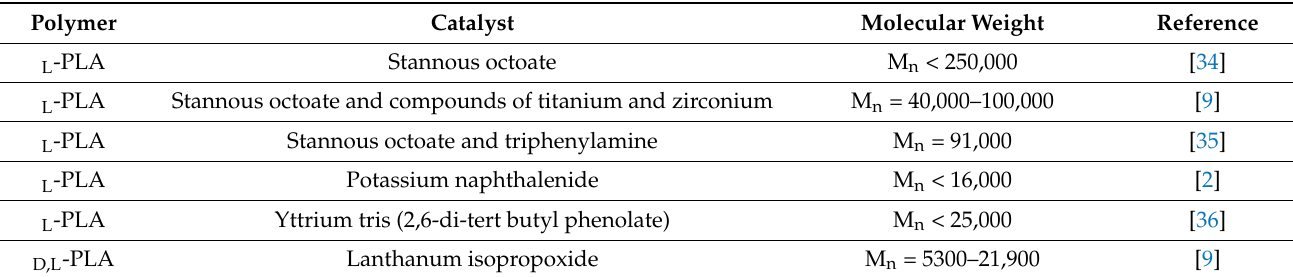
Table 1. Comparison of catalysts used in PLA synthesis.